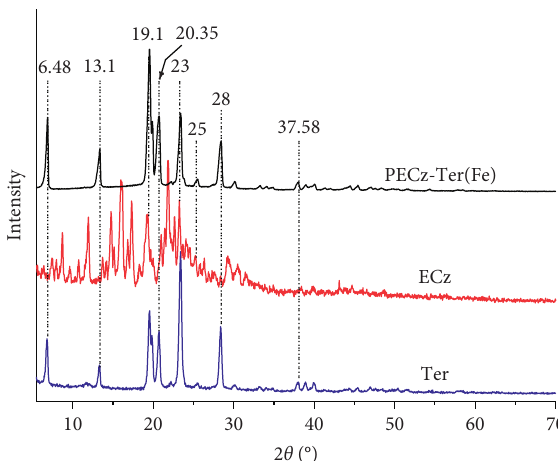
Figure 1: X-ray diffraction patterns of terphenyl (Ter), P-ethyl- carbazole (PEcbz), and PEcbz-Ter copolymer.